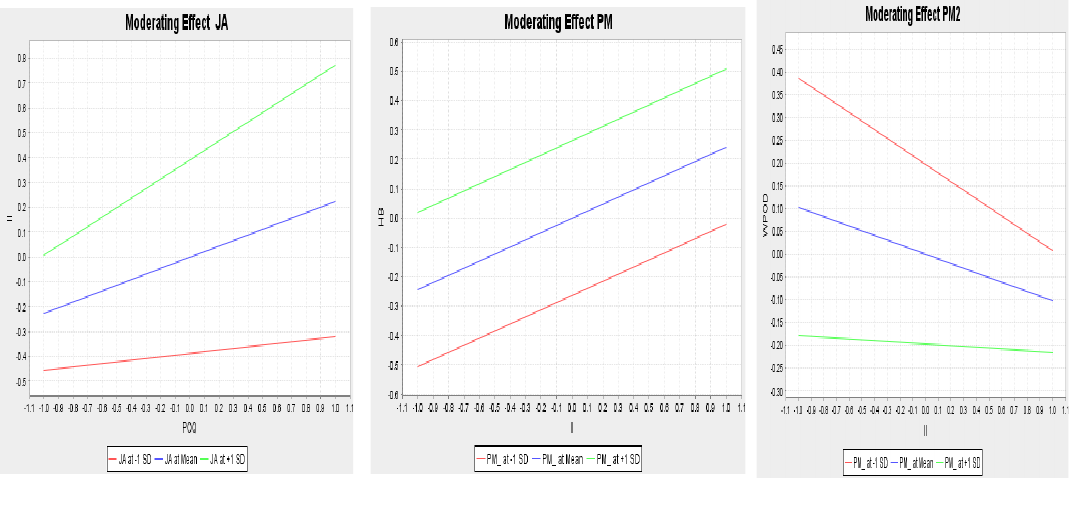
Figure 4: Moderation of